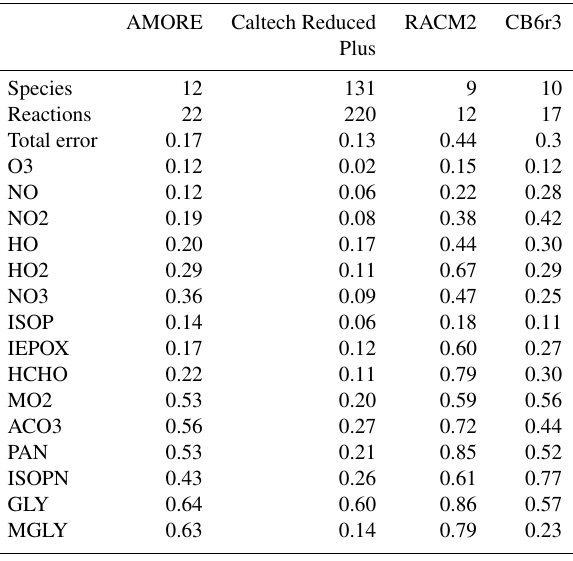
Table 6. Total error (individual species error described in Eq. 4, species weighting shown in Table 5, and further discussion in Sect. 2.4.4) and mechanism size for four reduced isoprene mech- anisms with the Caltech full mechanism as a basis of comparison. Individual species error shown averaged over the six tested condi- tions.